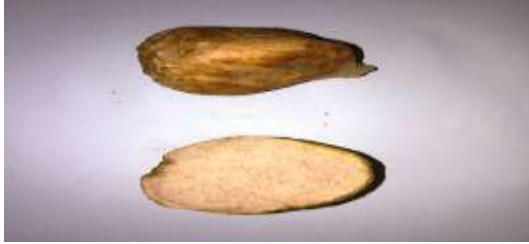
Figure 1. An ascocarp of Terfezia claveryi and a cross section of it.